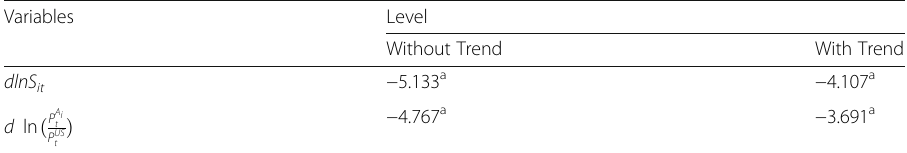
Without Trend With Trend − 5.133 a